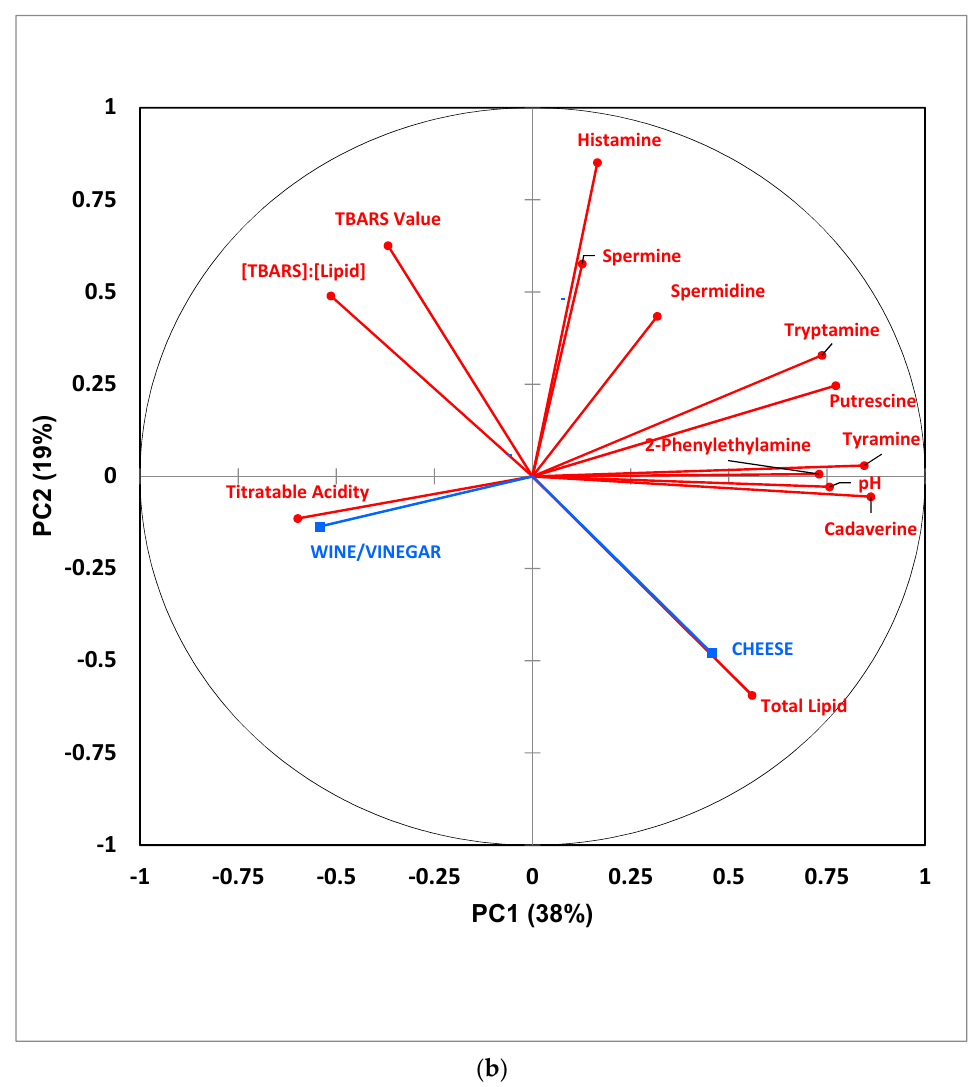
Figure 3. ( a ) 3D PCA scores plot of PC3 vs. PC2 vs. PC1, showing some degrees of distinction between di ff erent fermented food classes, i.e., those of cheese, fish, fish sauce / pastes, vegetable pastes, and wines / vinegars (particularly that between the wine / vinegar classification and all others). ( b ) Preliminary correlation circle diagram displaying correlations between all explanatory variables considered, and PCs 1 and 2 in a PCA model applied to the complete autoscaled (standardized) dataset. Active variables are depicted in red, whereas two of the supplementary variable classifications (cheese and wine / vinegar) are shown in blue. Variance contributions for PC1 and PC2 are